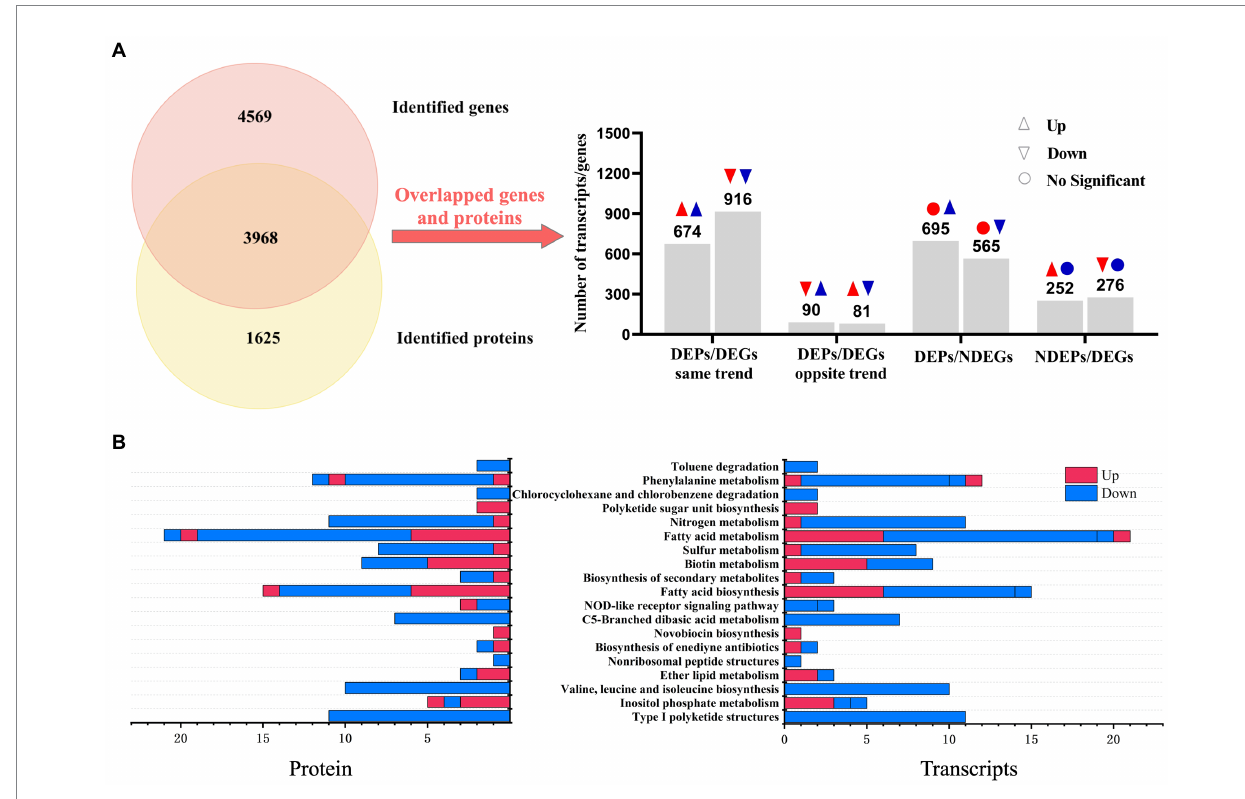
FIGURE 2 Association analysis of genes and proteins between the high ε -PL-producing mutant S. albulus WG-608 and its progenitor strain S. albulus M-Z18. (A) Numbers of overlapping gene/protein pairs that show the same or opposite trends in expression, or that show differential expression only at the protein or mRNA level between WG-608 and M-Z18. The red indicates transcript, blue indicates protein. (B) KEGG enrichment analysis of overlapping gene/protein pairs between S. albulus M-Z18 and S. albulus WG-608. Red represents pathways enriched with upregulated genes/proteins; blue represents pathways enriched with downregulated